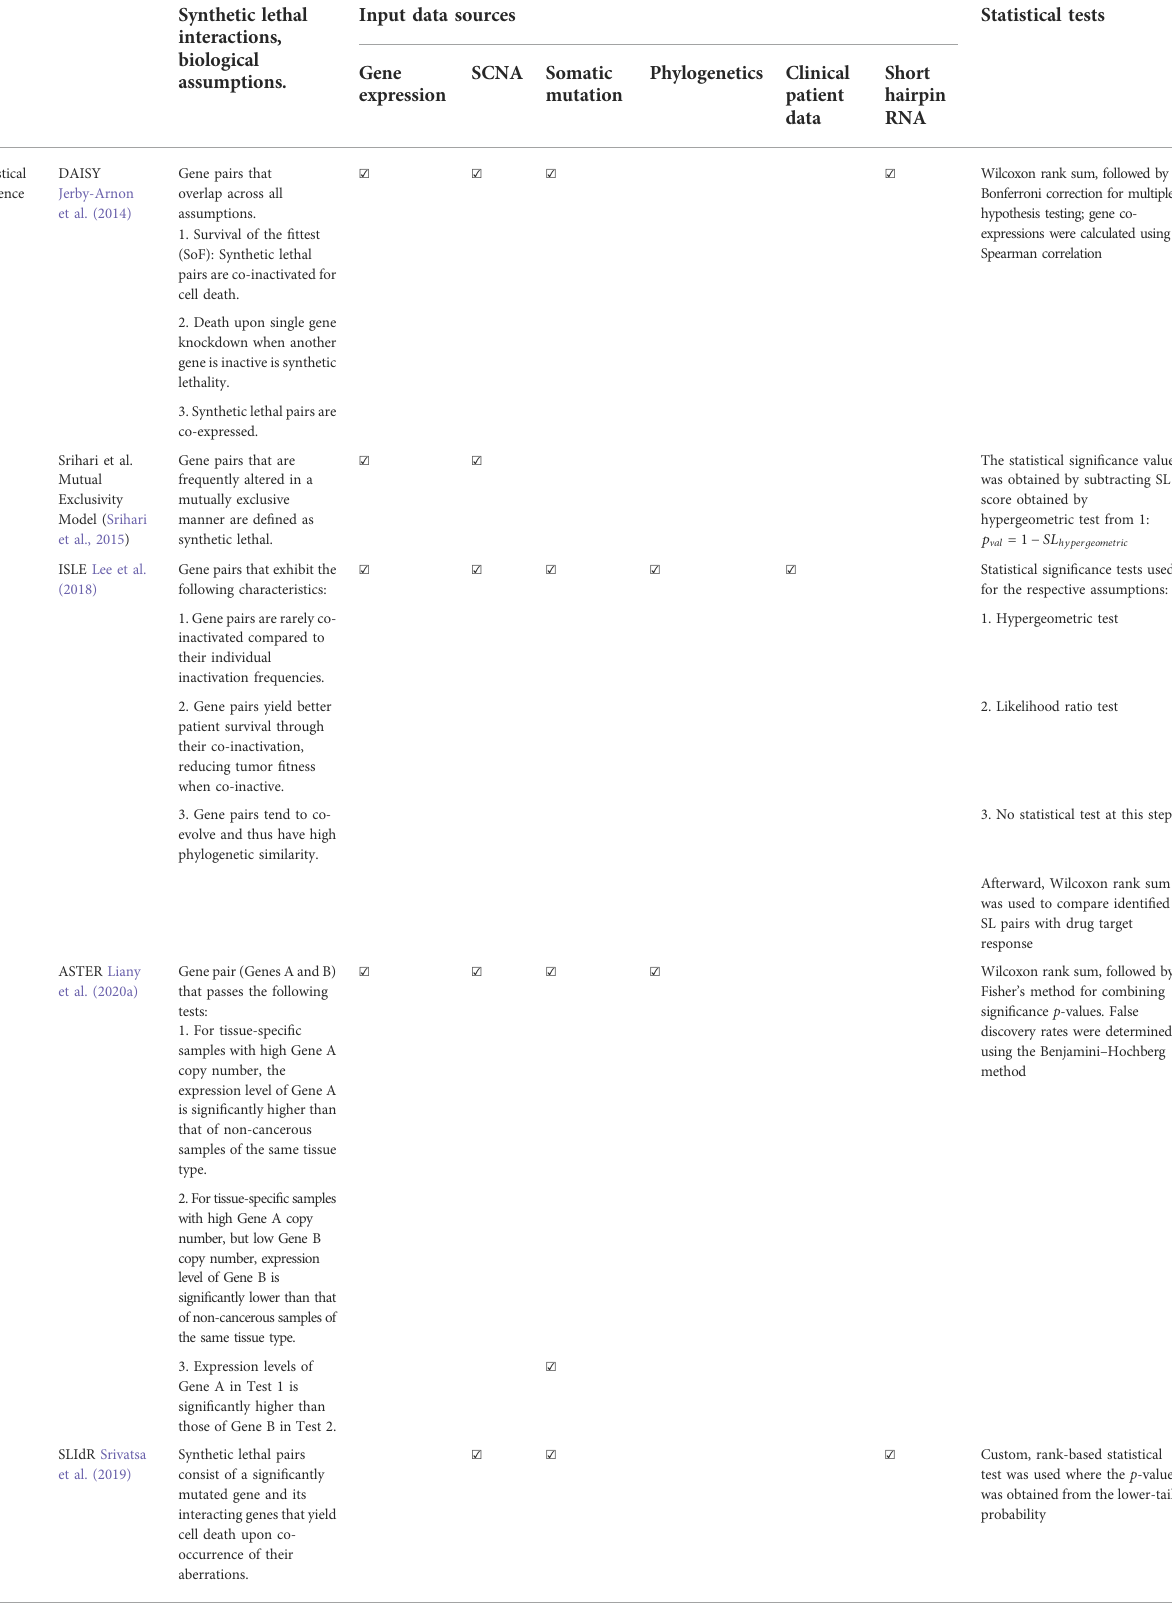
TABLE 2 Biological assumptions, sources of input data, and network statistics for predictive